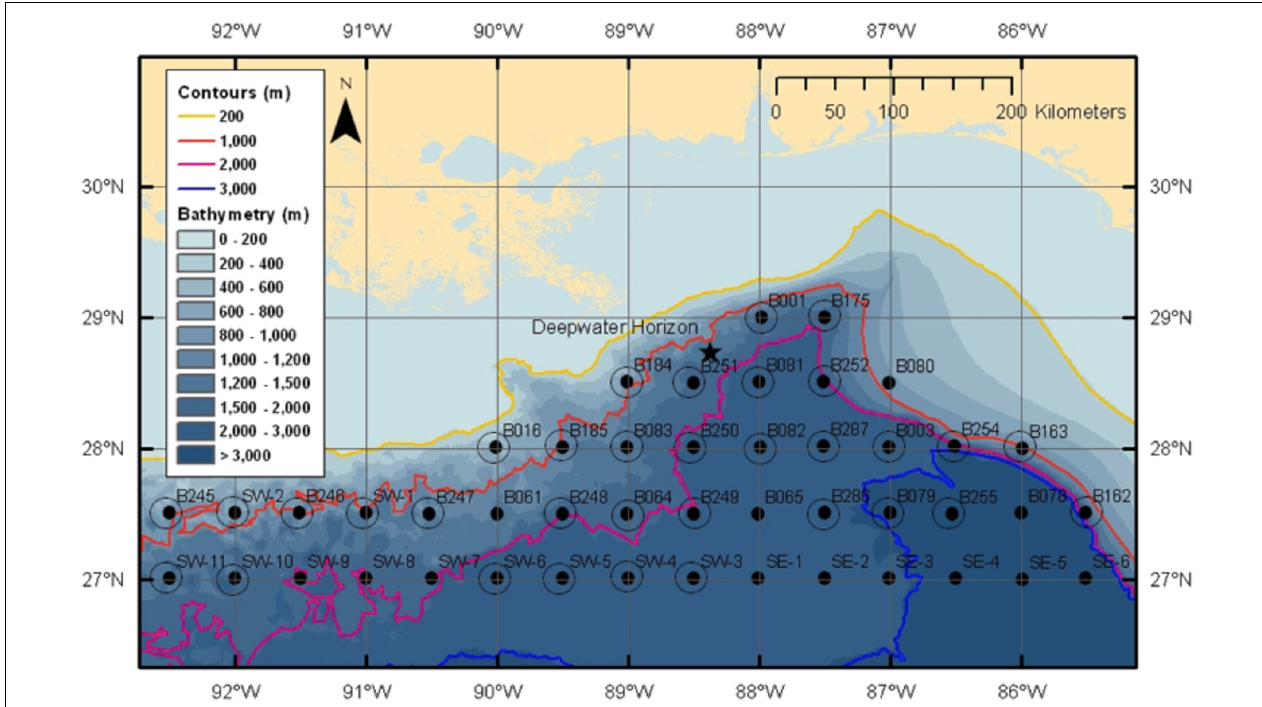
FIGURE 3 | SEAMAP sampling grid used by both ONSAP and DEEPEND cruises (Eldridge, 1988). Note the location of the DWH marked by a star. Yellow line marks the 200 m isobath, orange the 1000 m isobath, pink the 2000 m isobath, and blue the 3000 m